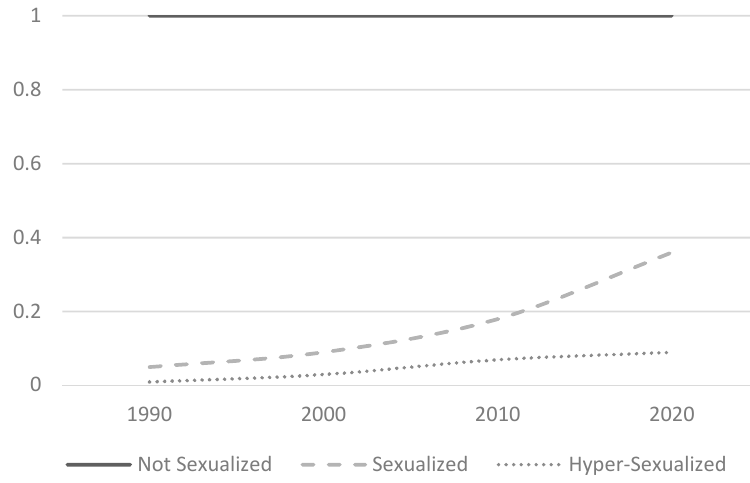
Figure 4. Sexualization over Time.